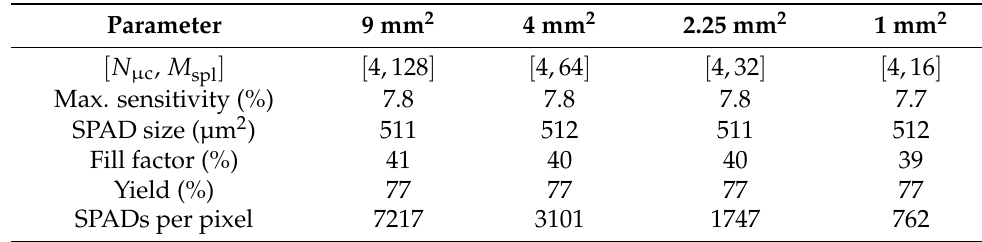
Table 2. SiPM calculated performance. The data were obtained by solving Equation (10), using the data from Table 1 and Figure